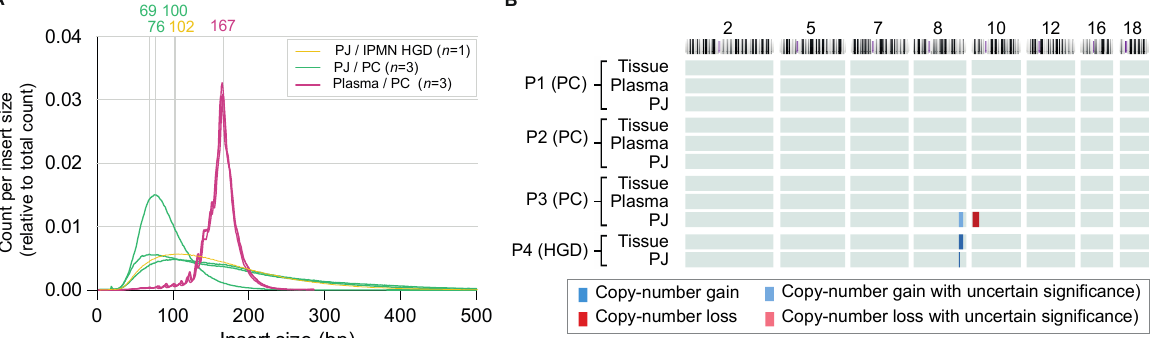
Figure 1. Results of pilot samples. ( A ) The fragment lengths’ distributions (insert size) in pilot PJ and plasma samples. No clear difference was seen between the intraductal papillary mucinous neoplasm (IPMN; yellow) with high-grade dysplasia (HGD) and pancreatic cancer (PC; green). PJ samples showed a mode of 69-102 base pairs (bp), whereas the fragment peak for the plasma samples (all PC) was 167 bp (pink). ( B ) Chromosomal aberrations in pilot samples. No significant aberrations were seen in plasma samples, whereas in pancreatic juice (PJ) an 8q gain with (P3) or without (P4) 10p loss was seen. For P4, this aberration was also found in